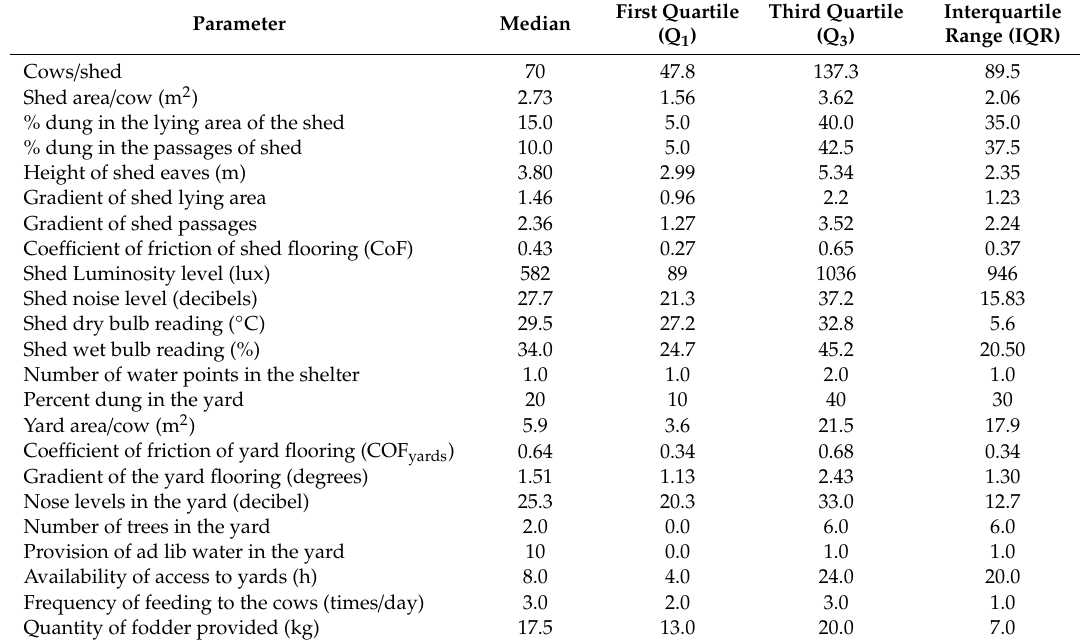
Table 1. Descriptive statistics of the resource-based welfare parameters in shelters ( n =